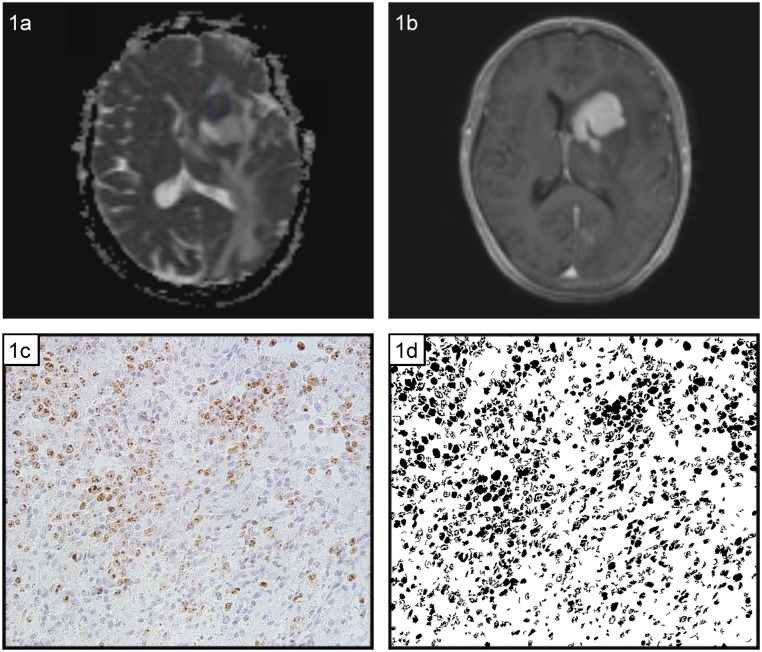
MRI and histopathological findings in a patient with diagnosed cerebral lymphoma.a. T1w image documenting a lesion with marked homogenous enhancement. b. ADC map. The ADCmin value of the lesion is 64x10-4mm2s-1, the ADCmean value of the lesion is 80×10−4 mm2s-1 and the ADCmax value is 133×10−4 mm2s-1. c. Immunohistochemical stain (MIB-1 monoclonal antibody). Ki 67-index = 50%. d. “Particles tool” analysis image (ImageJ converted MIB-1 image). Cell count (total number of nuclei in the image), total nucleic area (total area of all nuclei in the image) and average nucleic area (total area of all nuclei in the image divided by the number of nuclei in the image) were calculated via the particles tool in ImageJ. For the image shown in fig 1d the following values were determined by the “Particles tool” analysis; cell count = 1424, total nucleic area = 105678.14 μm2 and average nucleic area = 74.37 μm2.